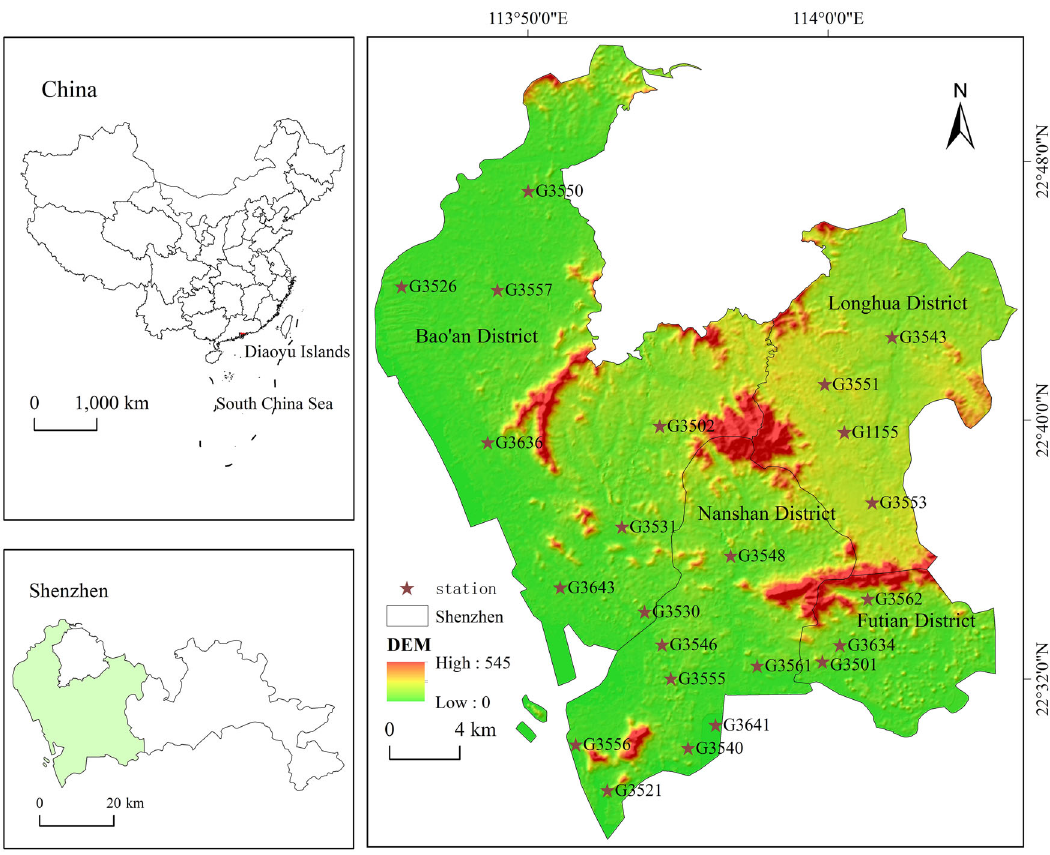
Fig. 9 The location of study area (Shenzhen, China). All panels show the geographic location map of the study area. The upper left panel represents the distribution of the study area in China, the lower left panel represents of the study area the distribution in Shenzhen City, and the right panel shows the speci fi c extent of the study area and the distribution of stations and